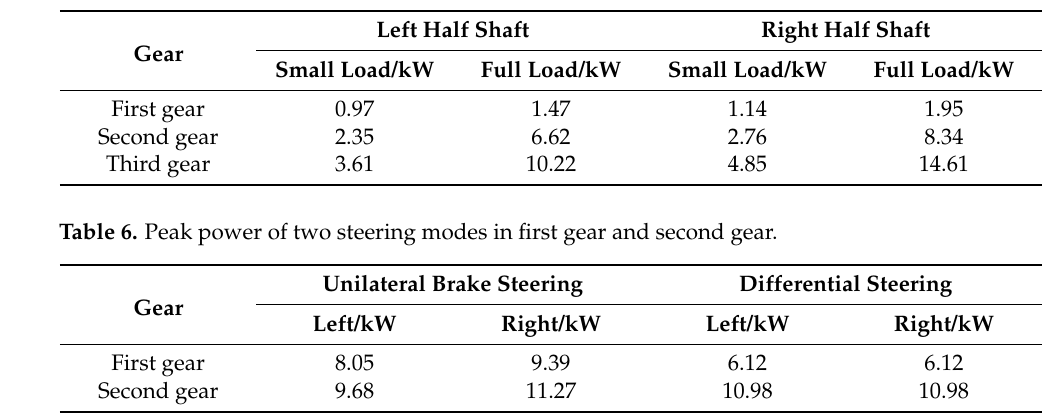
Table 5. Proportion of working time under different working